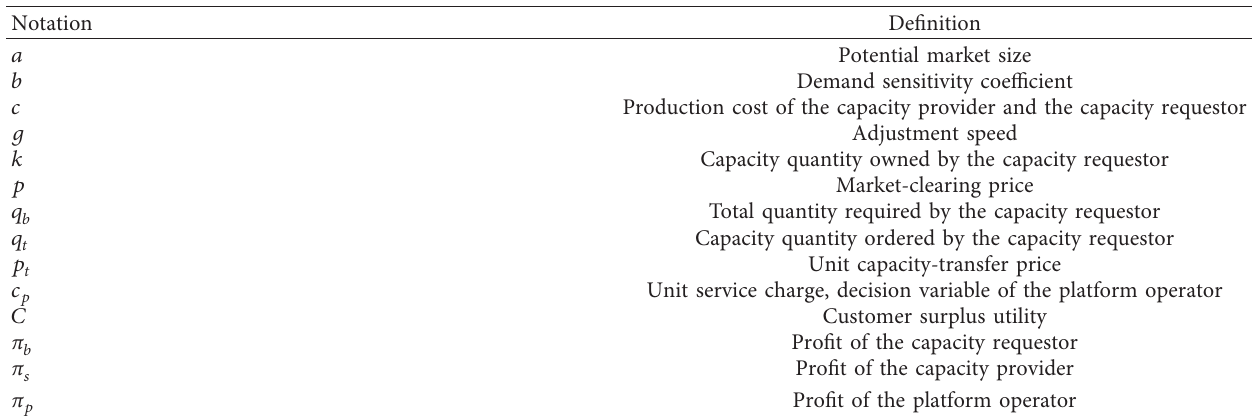
Figure 2: Sequence of events. Table 1: List of